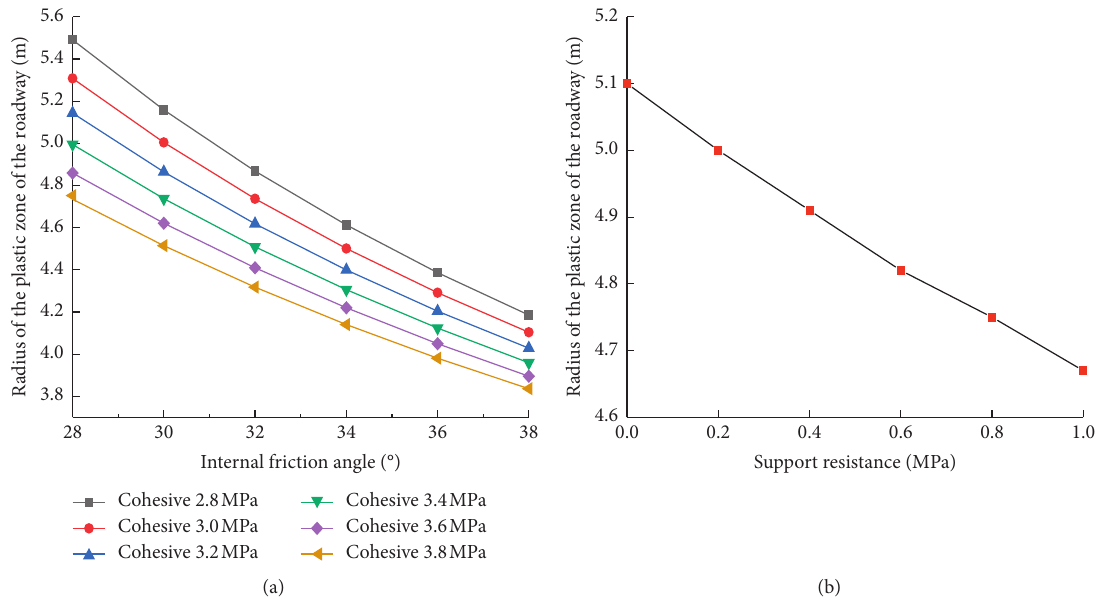
Figure 8: Influence of surrounding rock parameters on radius of the plastic zone of the